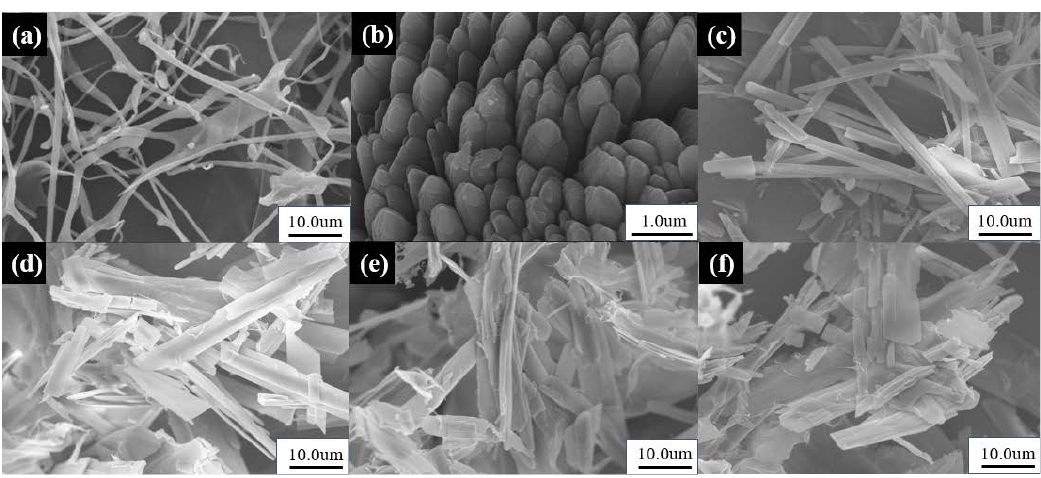
Figure 2. The SEM images of ( a ) TC aerogel, ( b ) Res, ( c ) R:T=1:2, ( d ) R:T=2:3, ( e ) R:T=3:2, ( f ) R:T=2:1.